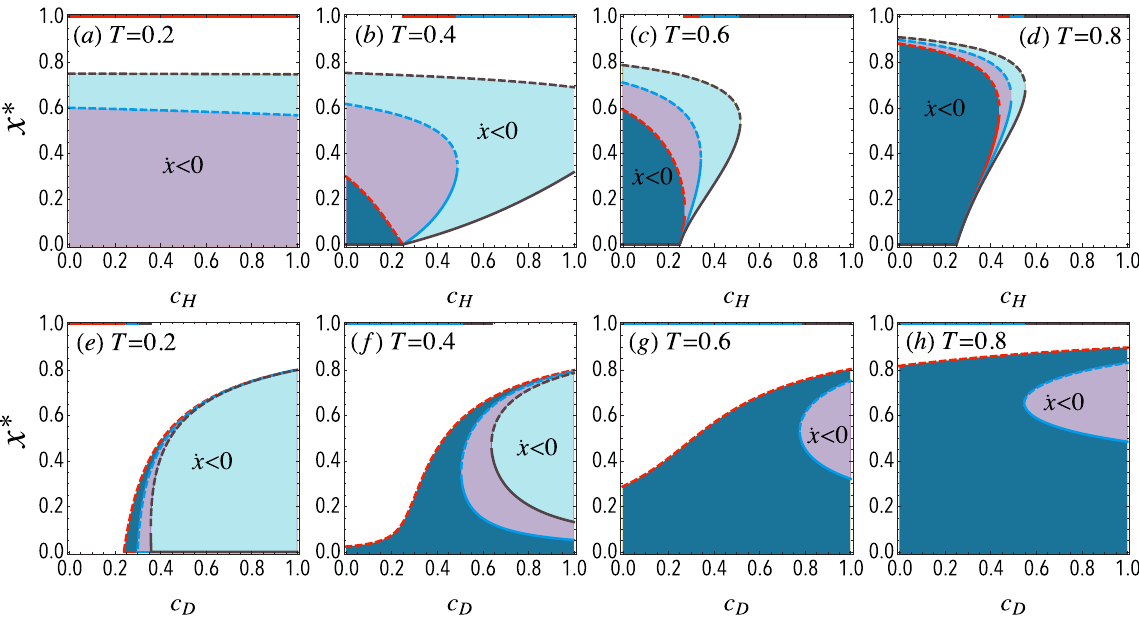
Figure 3. Equilibria of the N-person Hawk-Dove Game with threshold in infinite populations. Fraction of doves x * at the equilibrium for a sample size of N = 5. Solid ( resp ., dashed) line corresponds to stable ( resp ., unstable) equilibrium. Top panels represent x * as a function of the hawks’ cost c H . Different color lines stand for different doves’ costs: red, blue and gray lines represent c D = 0.2, 0.5, 0.8 respectively. The bottom panels represent x * as a function of the doves’ cost c D . Different color lines stand for different hawks’ costs: red, blue and gray lines represent c H = 0.2, 0.5, 0.8 respectively. Shaded areas denote a negative gradient of selection. (a,e), (b,f), (c,g) and (d,h) panels correspond to thresholds T = 0.2, 0.4, 0.6, 0.8 respectively. The resource is taken as unity R = 1. See the main text for further